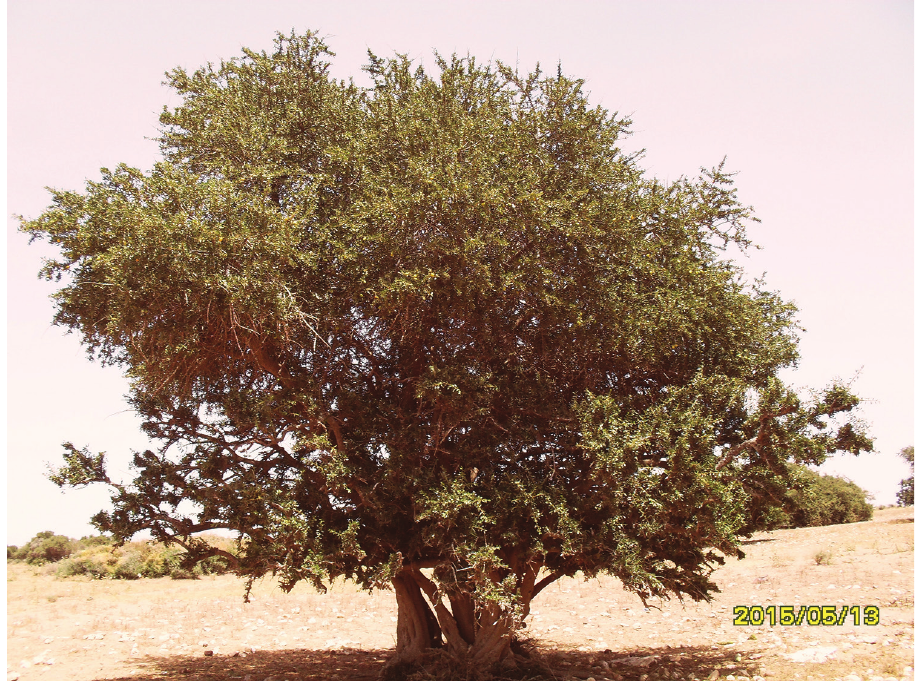
Figure 1. Argania spinosa L. host plant of Ceratitis capitata